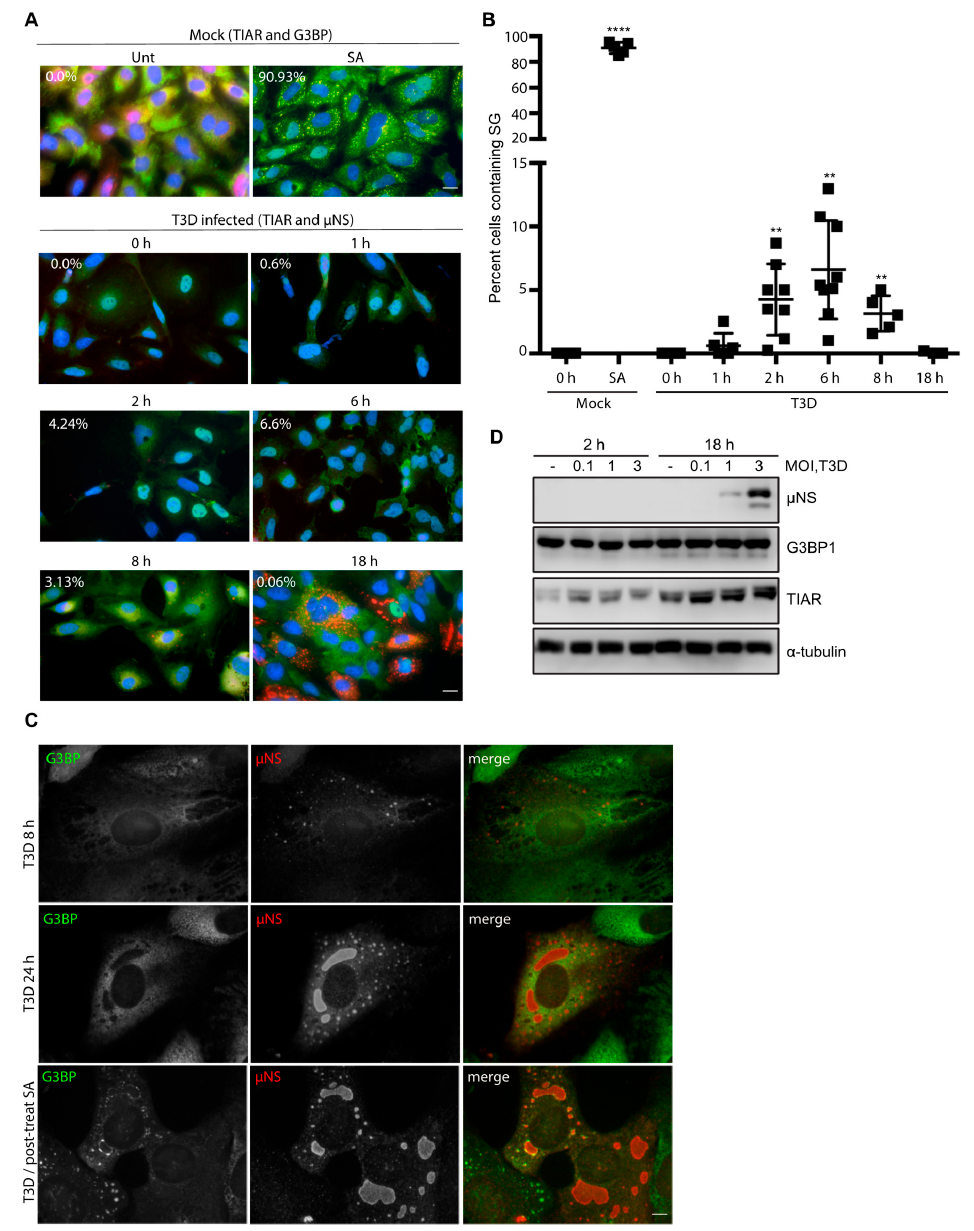
Figure 1. Reovirus infection induces the formation of stress granules (SGs) at early times post infection ( A ) CV-1 cells were mock infected, pre-treated with 0.5 mM sodium arsenite (SA) for 30 min, or infected with type 3 Dearing (T3D) at a multiplicity of infection (MOI) = 10. At the indicated times, cells were fixed and co-immunostained for G3BP (red) and TIAR (green), upper panels, to detect SGs in uninfected cells or TIAR (green) and µ NS (red), lower panels, to detect SGs in T3D-infected cells. Cell nuclei were stained with DAPI (blue). Mock cells were fixed at 18 h. Scale bars, 20 µ m. ( B ) The percent of cells containing SGs from panel (A) was quantified ((# of cells containing SGs / total # of cells) × 100) from a minimum of three independent experiments. ** p < 0.01, **** p < 0.0001; two-tailed unpaired t test. The error bars indicate S.D. ( C ) CV-1 cells were infected with T3D at an MOI = 0.5 and at 8 and 24 h p.i. cells were fixed and co-immunostained with G3BP (green) and µ NS (red), upper panels. Alternatively, CV-1 cells were infected with T3D at an MOI = 1 and at 23.5 h cells were post-treated with 0.5 mM SA for 30 min. At 24 h p.i., cells were fixed and co-immunostained with G3BP (green) and µ NS (red), lower panels. Scale bars, 10 µ m. ( D ) Cells were either mock infected (-) or were infected with T3D and, at the indicated times, cells were lysed and the expression level of proteins was determined by